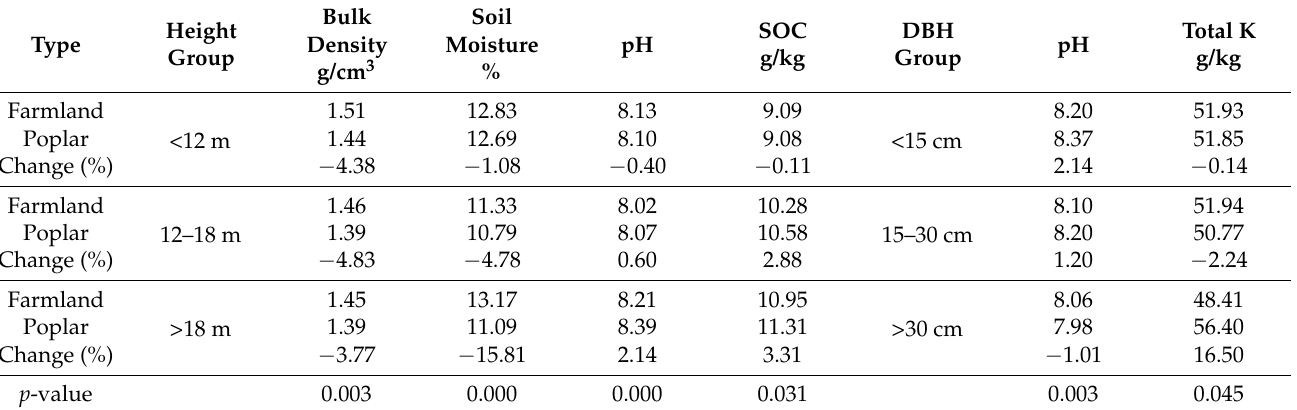
Table 5. Shelterbelt construction and tree growth stage significantly affected 5 soil parameters (marked type*height, and type*DBH interactions, p < 0.05) and magnitudes and patterns of the influences. The non-significant factors ( p > 0.05) were not listed